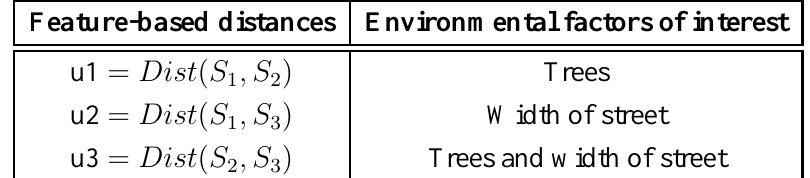
Table 8. Environmental factors of interest of each feature-based